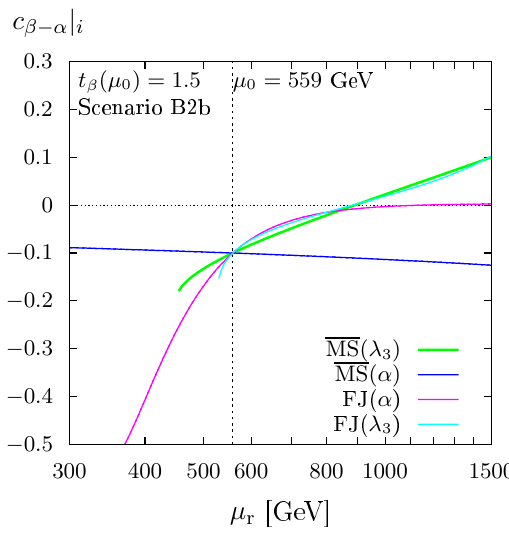
Figure 28 . The running of c (cid:12) (cid:0) (cid:11) for scenario B2b for the di(cid:11)erent schemes in the colour code of (cid:12)gure 9. Note that the turquoise line follows the pink line for (cid:22) r close to (cid:22) 0 and the green line for larger (cid:22) r